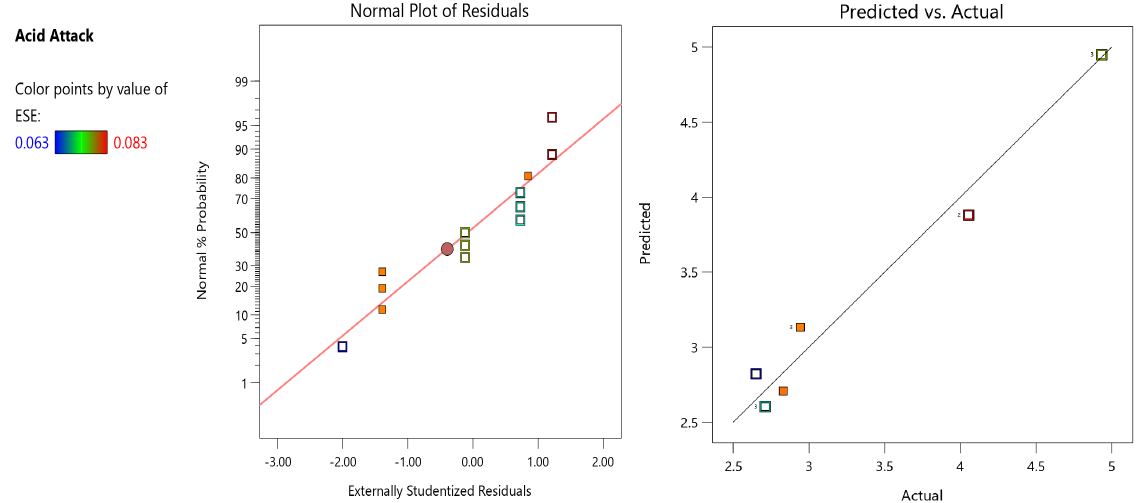
Figure 18. Normal plot for residuals, and actual vs. predicted values for acid attack test.